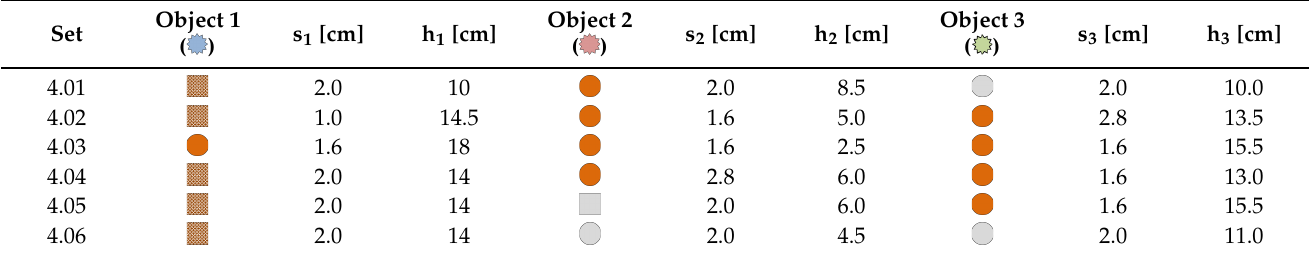
Figure 9. Comparison between measured (red line) and simulated (blue line) data by K-Wave Matlab toolbox for the amplitude ( a ) and phase ( b ) signals. Table 5. Scenario 4: three objects of different size, shape and material (Figure 8). The quantity s refers to the diameter for spherical objects and to the side for